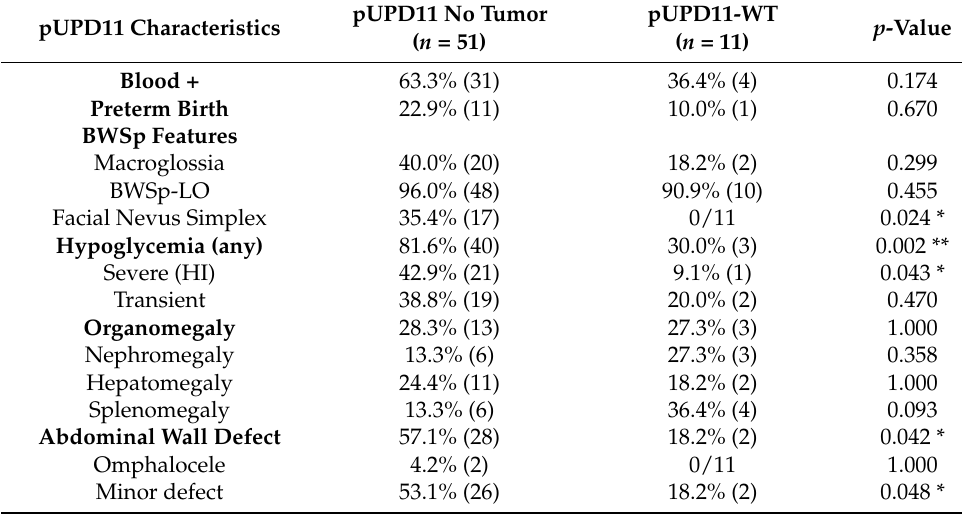
Table 10. Wilms tumor (WT)-associated phenotypes within pUPD11 population.